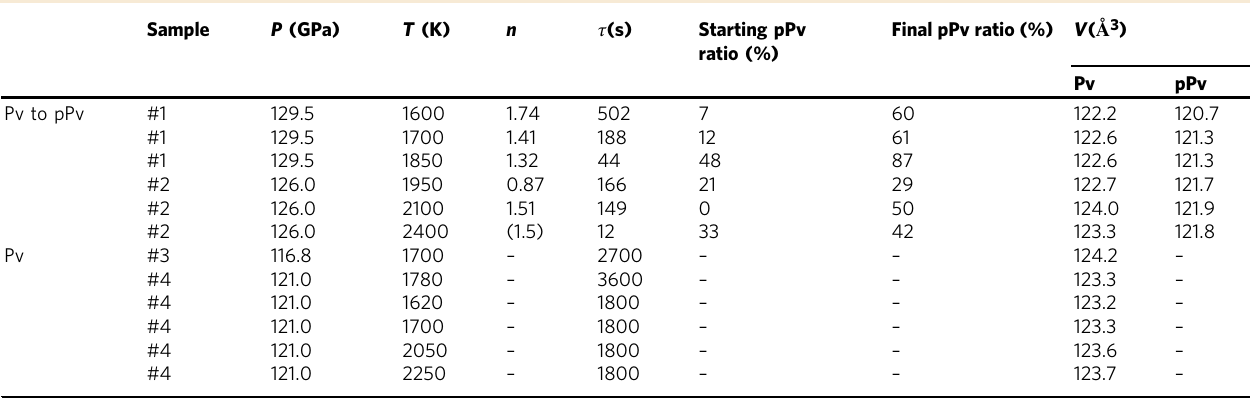
Table 1 Conditions for the different